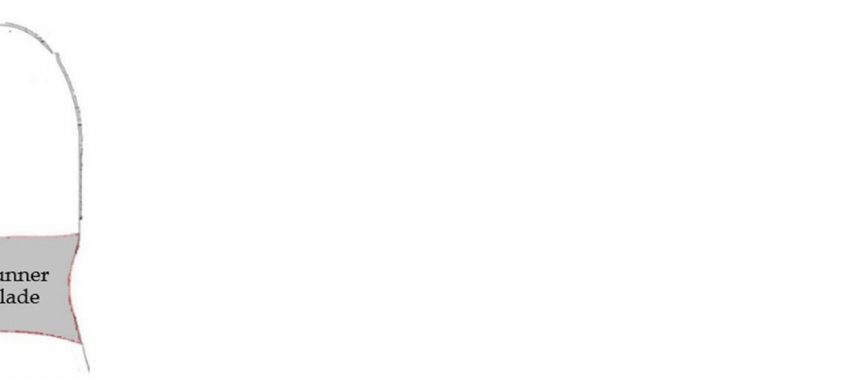
Figure A8. Guide vanes as the antennas for the hydro-acoustic waves stemming from the cavitation on the runner function differently for cavitation in different locations. The reception for the blade- surface cavitation might be fully or partially blocked by the shadow of the runner blade’s body at some angular settings of the runner, i.e., at some loads. The reception is clearer for the waves coming from the cavitation on the blade’s edge, thus also for the tip